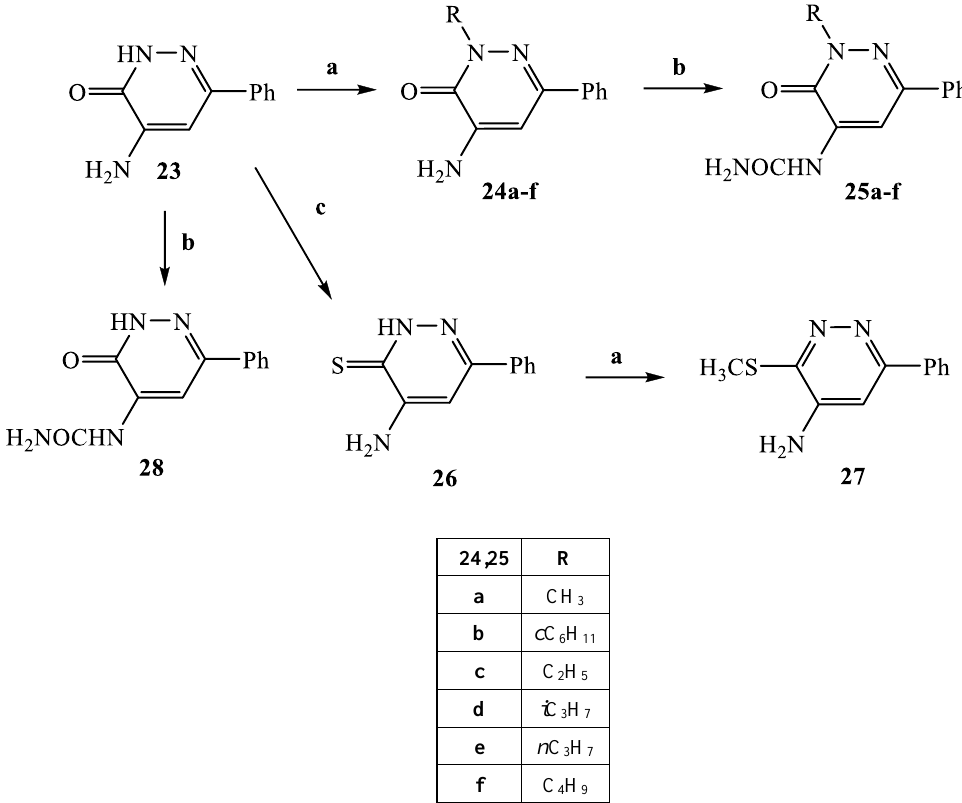
Scheme 4. Reagents and conditions: ( a ) suitable R-Br, K 2 CO 3 , anhydrous DMF, reflux, 1–4 h; ( b ) (i) dry THF, CH 3 COONa, 0 °C then triphosgene, reflux, 2 h; (ii) NH 3 33%, 0 °C, 1 h; ( c ) Lawesson ’ s reagent, anhydrous toluene, reflux, 5 h.